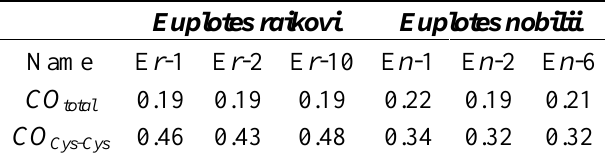
Table 3. The contact order calculated using all native contacts and the contact order calculated only for Cys-Cys native contacts are reported for the investigated